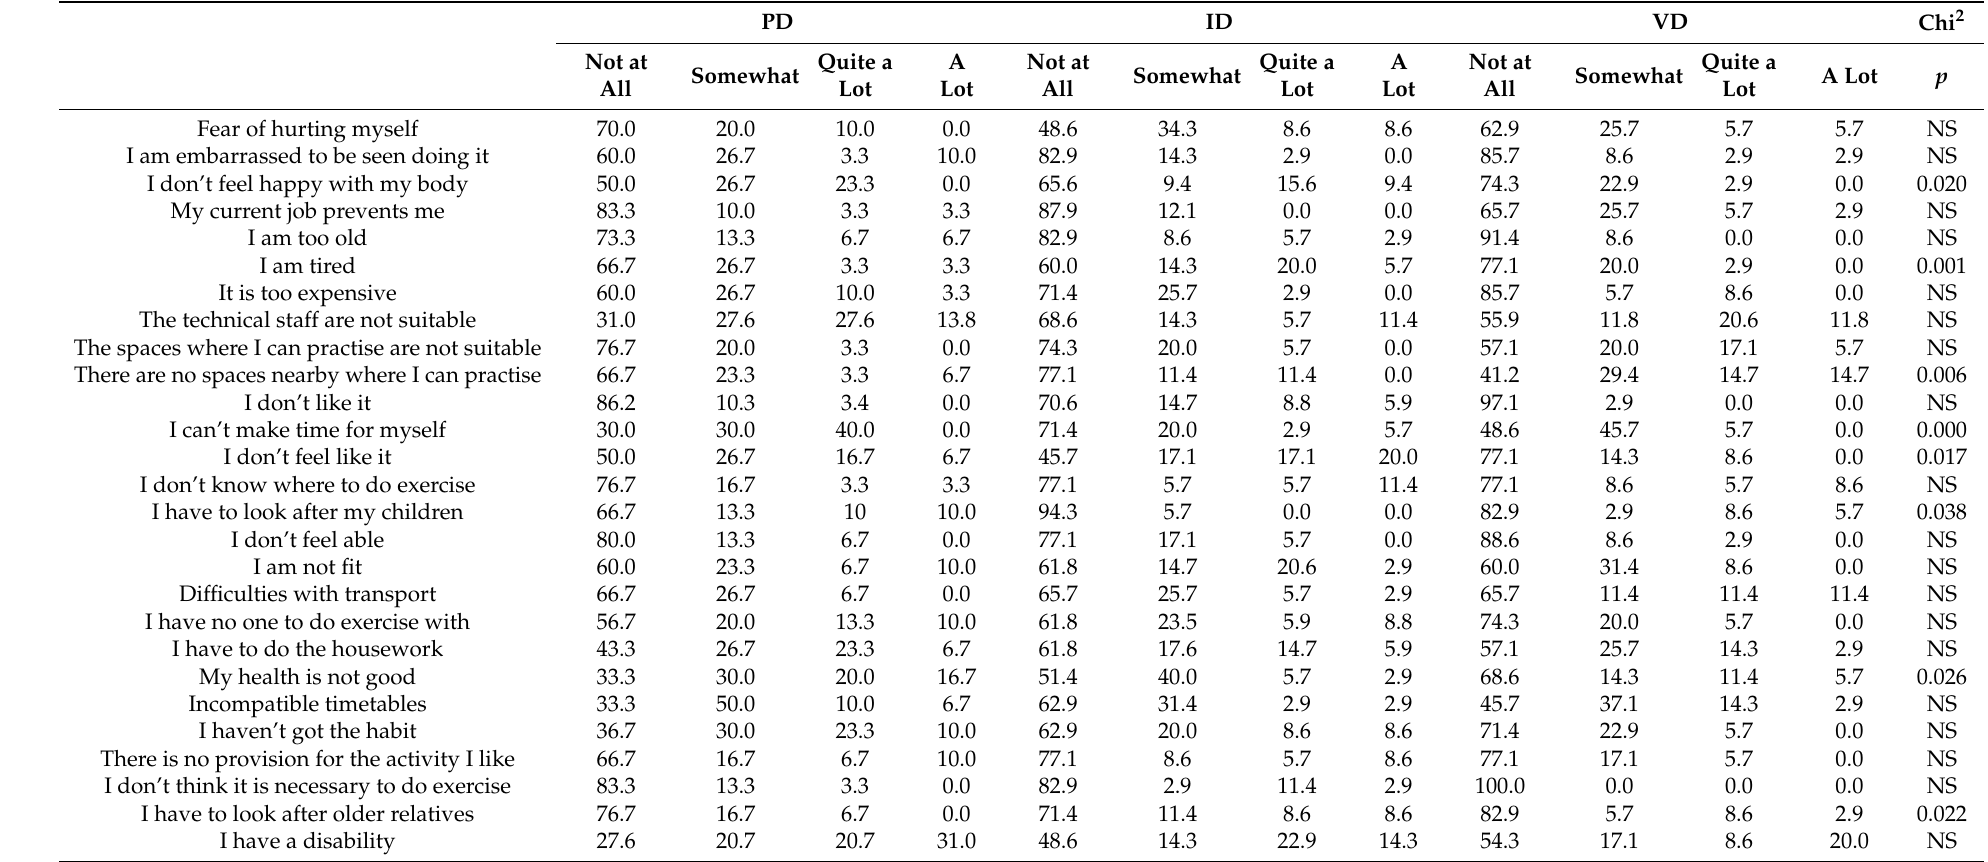
Table 5. Results (%) referring to the differences in the perceived barriers to practising PA and sport according to the type of